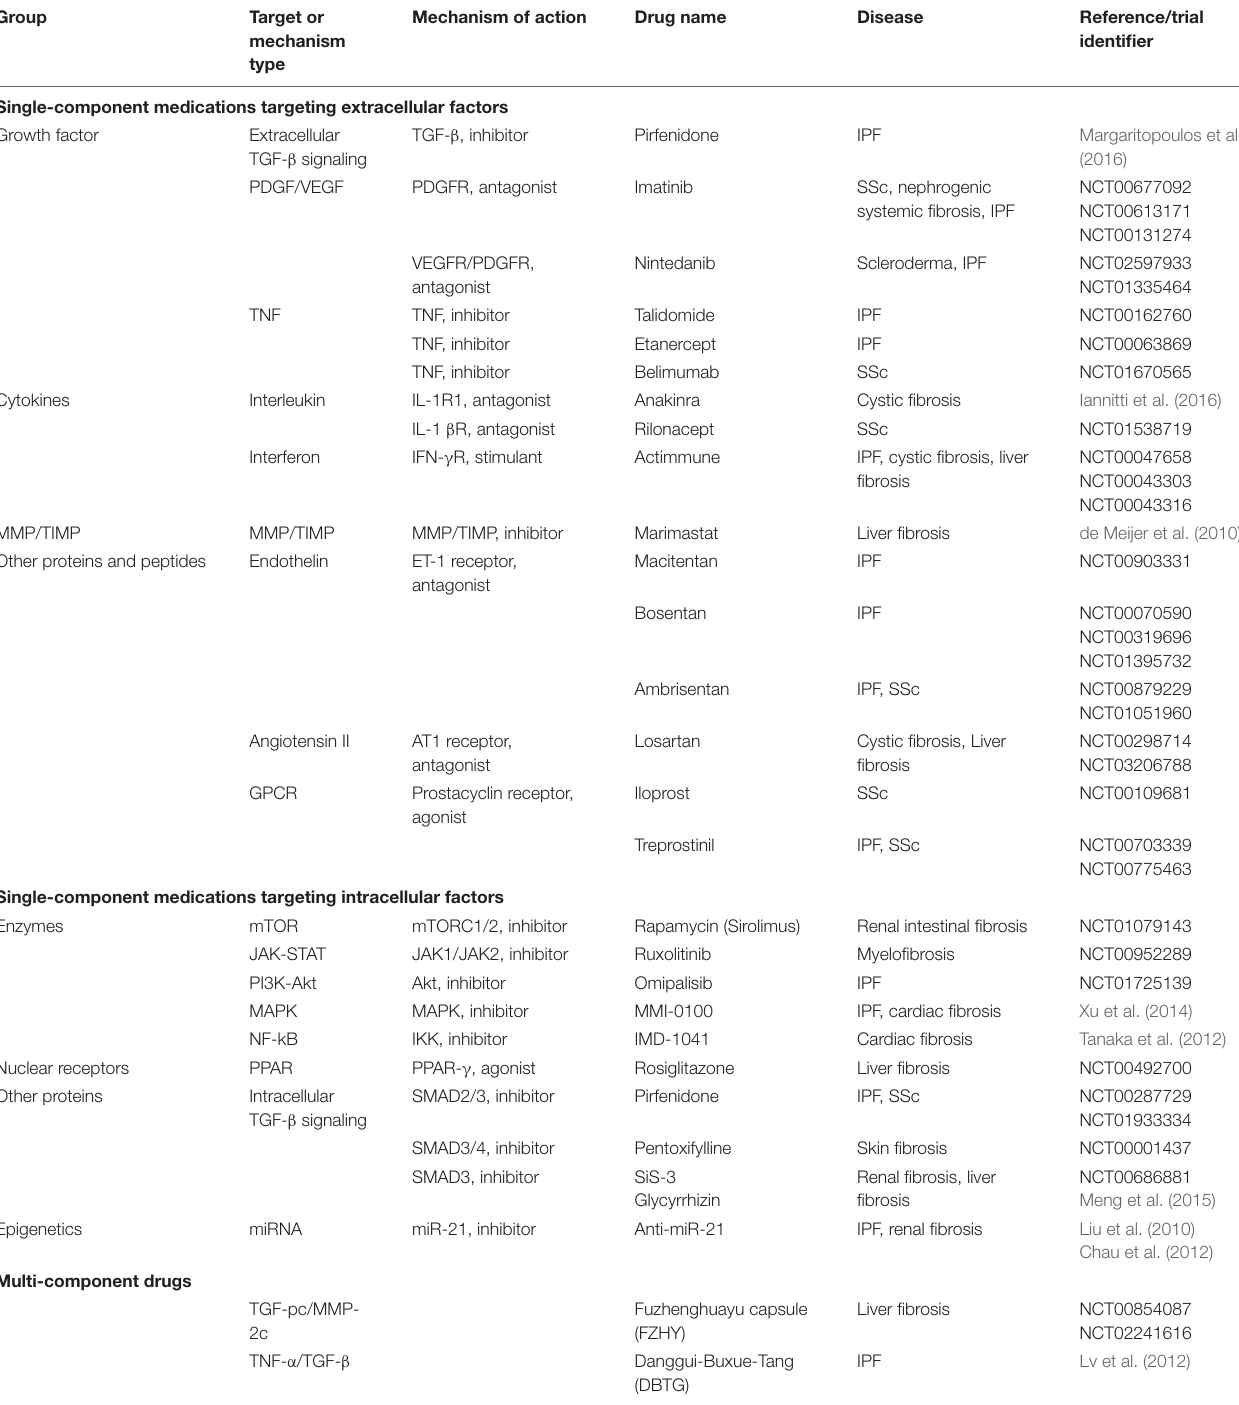
TABLE 3 | Single- and multi-component medications targeting fibrosis